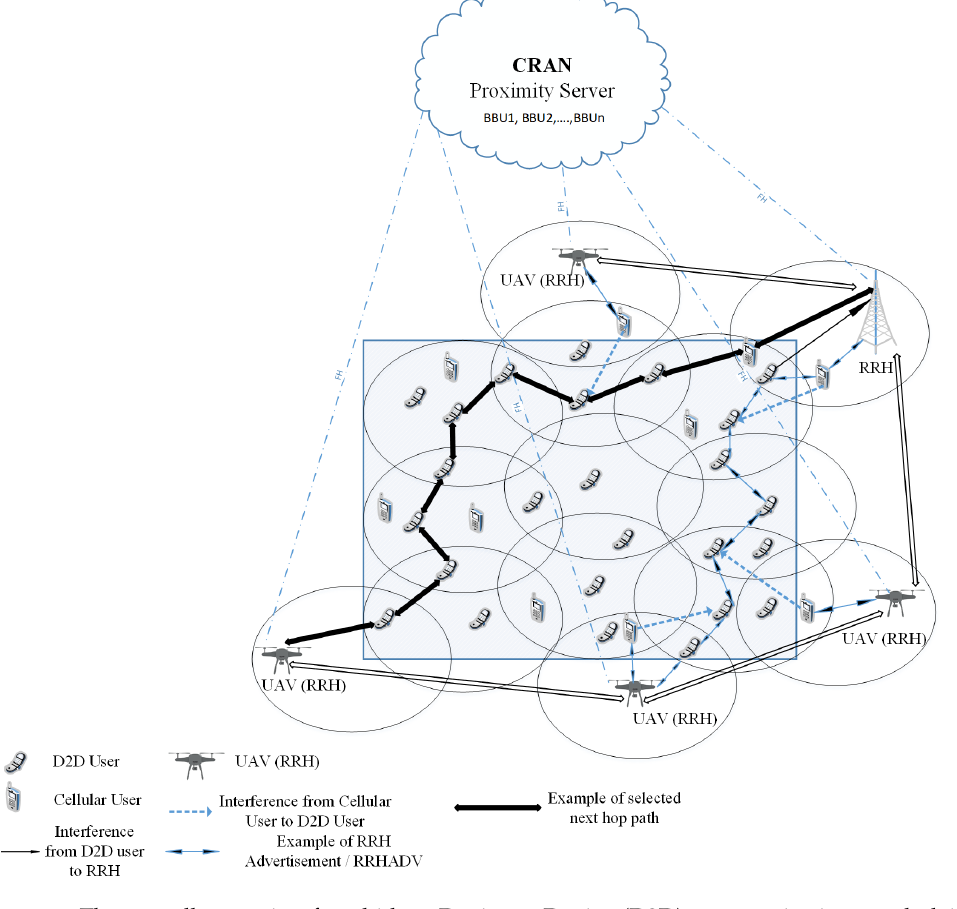
Figure 1. The overall scenario of multi-hop Device-to-Device (D2D) communications underlaid centralized radio access network (C-RAN) for public safety